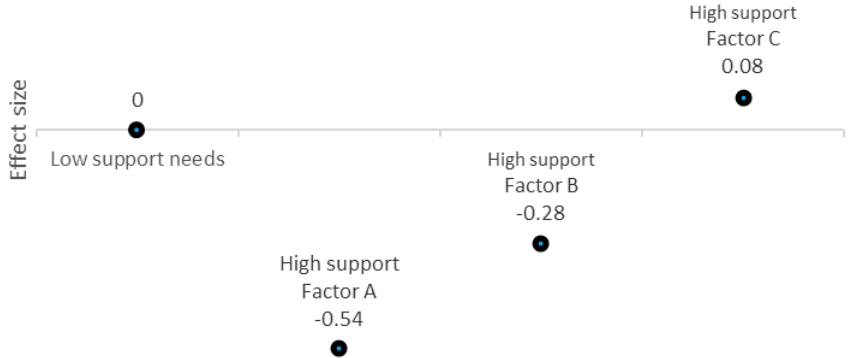
Figure 1. Mean differences according to the extent of support needs. Note: A, B and C factors cor- respond to professional practices oriented to promote the rights included in Articles 19, 22 and 26 of the Convention, respectively.